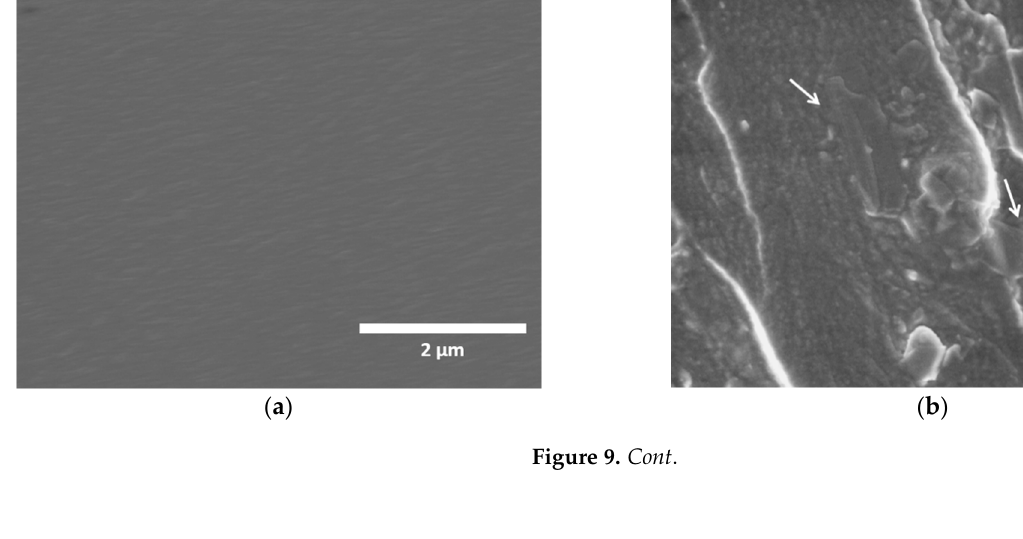
( d ) ( e ) Figure 9. SEM images of fractured sections of ( a ) Epoxy, ( b ) Epoxy/f-MoS2-0.1wt%, ( c ) Epoxy/f-MoS2-0.25wt%, ( d ) Epoxy/f-MoS2-0.5wt% and ( e ) Epoxy/f-MoS2-1.0wt%. 3.3.4. Flexural Properties The flexural properties of neat epoxy and Epoxy/f-MoS 2 nanocomposites are com- pared in Figure 10. F-MoS2 nanoplatelets improved the flexural properties of epoxy nanocomposites for the entire range of loading percentage, although the degree of im- provement varied with the loading level. Like the trend observed in the compressive and the fracture properties, nanocomposites modified with 0.25 wt% of f-MoS 2 nano- platelets give rise to a maximum increase of 64% in flexural strength compared to the neat epoxy. The flexural strength of the Epoxy/f-MoS 2 -0.25 wt% corresponds to 143 MPa, which is significantly high compared to the flexural strength of 87 MPa observed for the